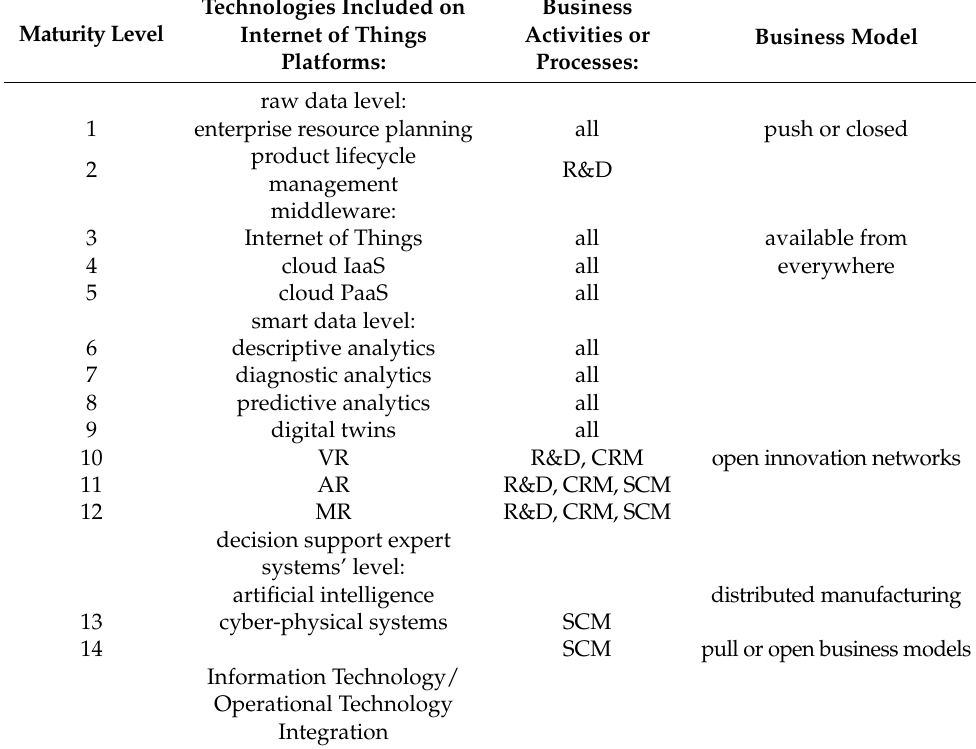
Table 2. Digital enterprise